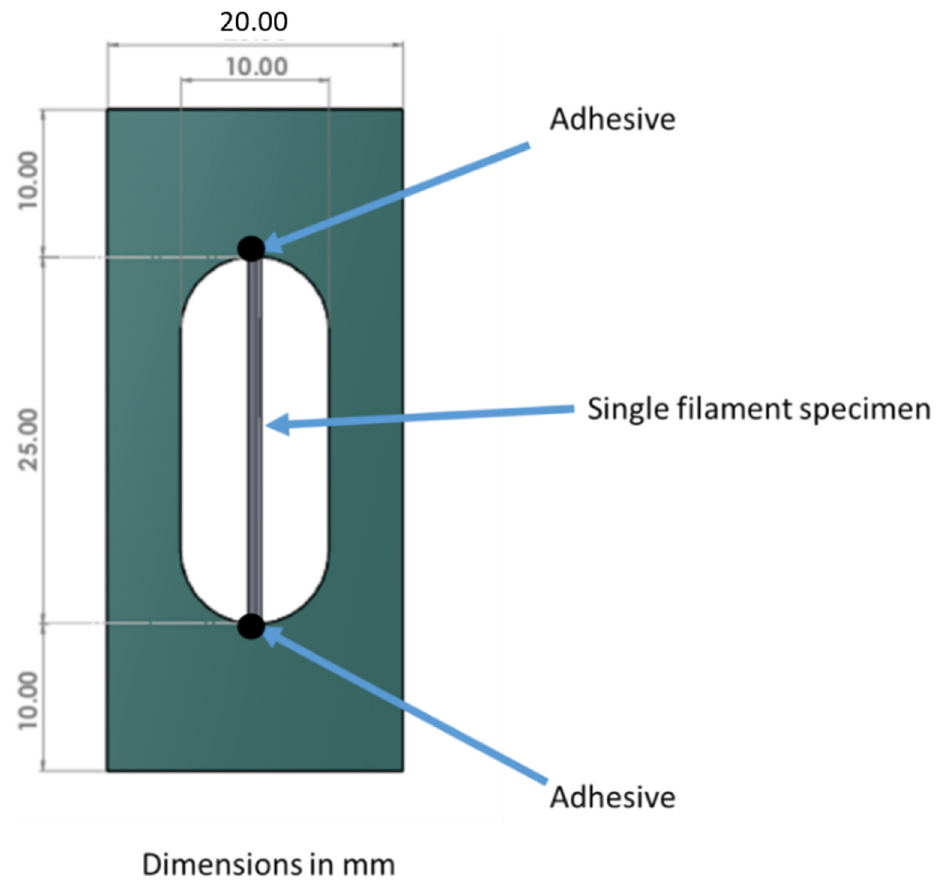
Figure A1. Tensile test setup for melt spun MP/PE fibre.